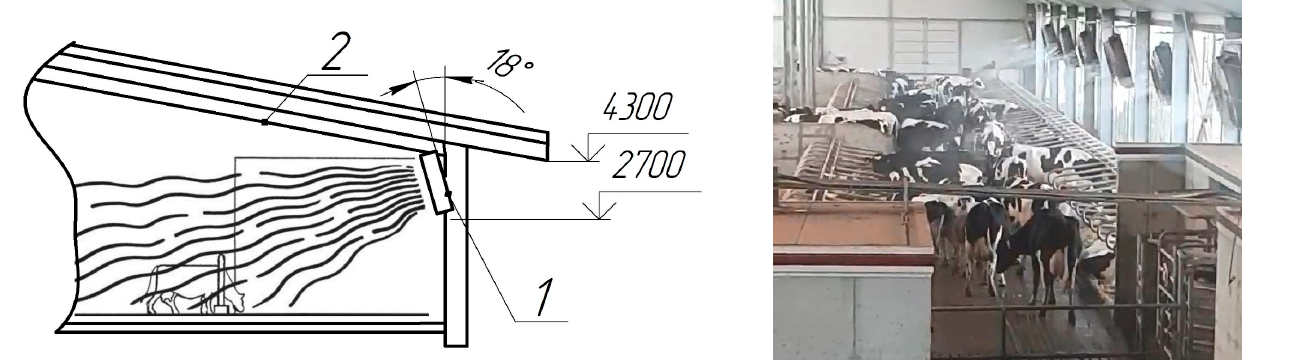
Figure 1. General view of a cowshed and an air humidification–cooling system: 1—fan; 2—cowshed (the photo was taken by the authors of the paper).